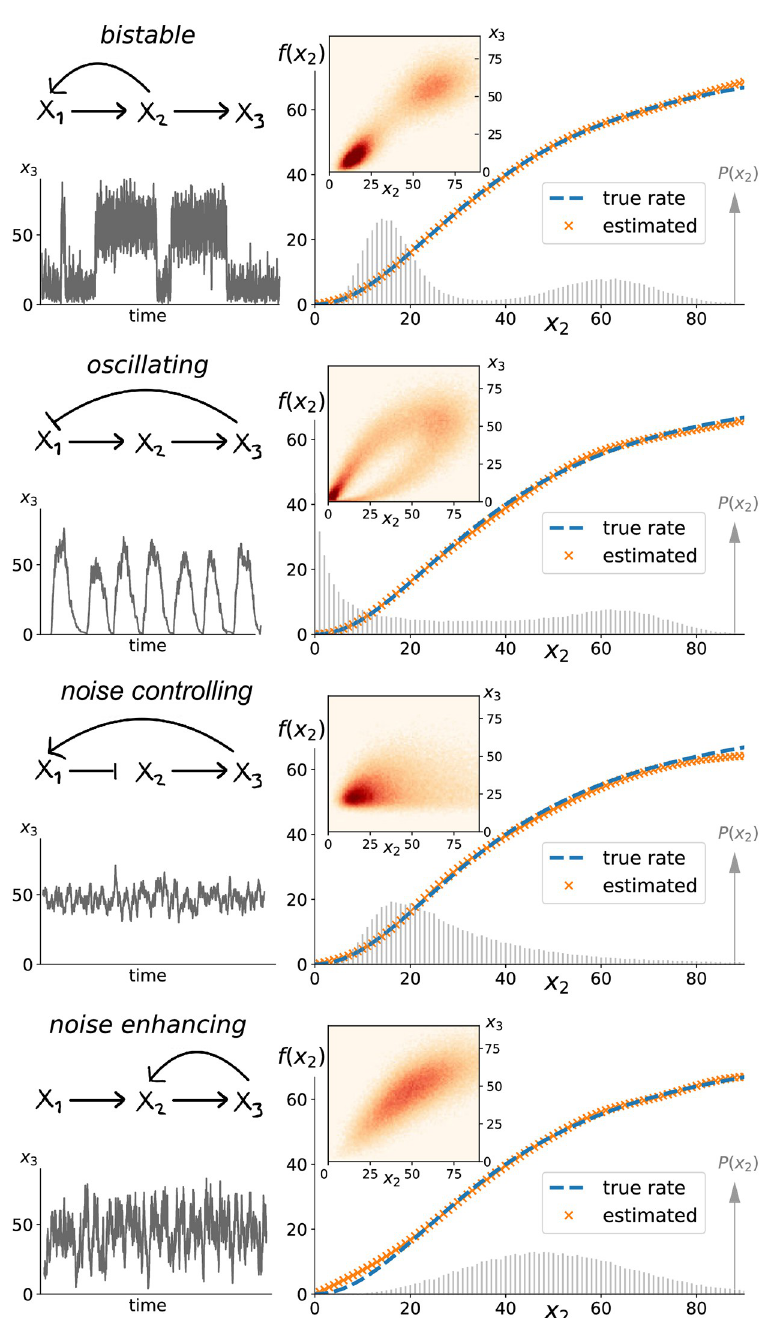
Fig 2. Probability flux balances can determine biochemical rates regardless of global network dynamics. Fixing how the production rate f ( x 2 ) of X 3 depends on X 2 -levels, we considered four different global network topologies within the class defined by Eq (3), that exhibit diverse system dynamics and variability in X 3 (left column). The insets of the right column depict numerically observed joint distributions P ( x 2 , x 3 ) corresponding to 100,000 independent snapshots. Although probability distributions differed greatly between the four systems, Eq (4) could identify the functional dependence of the production rate of X 3 based on the numerical convex optimization algorithm detailed in the Materials & Methods. We find near perfect agreement between the inferred rate (orange crosses) and the true rate function (dashed blue line) regardless of a system’s global dynamics. This inference of f ( x 2 ) does not utilize any temporal information, its only input is the stationary joint probability distribution between the two components of interest. It relies on observing fluctuations across a wide range of X 2 -states as illustrated by the shaded probability distribution P ( x 2 ) with deviations occurring where X 2 was rarely or never observed. While the degradation rate of X 3 was assumed to be known, no information about how its production rate depends on X 2 , or the dynamics of X 1 , X 2 was